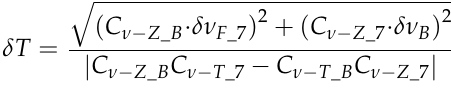
ment method of temperature and acoustic impedance.